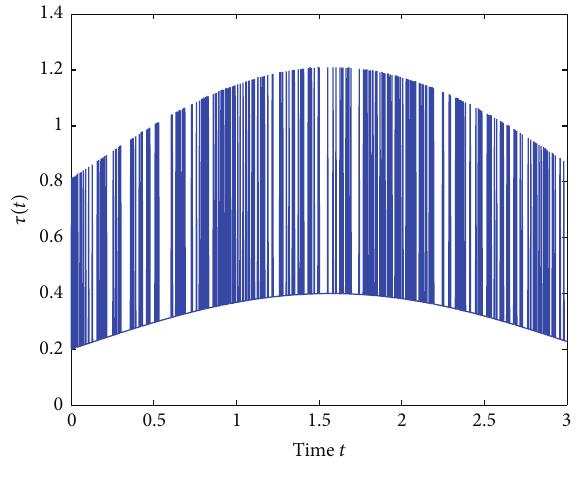
Figure 1: Random coupling delay 𝜏(𝑡) .